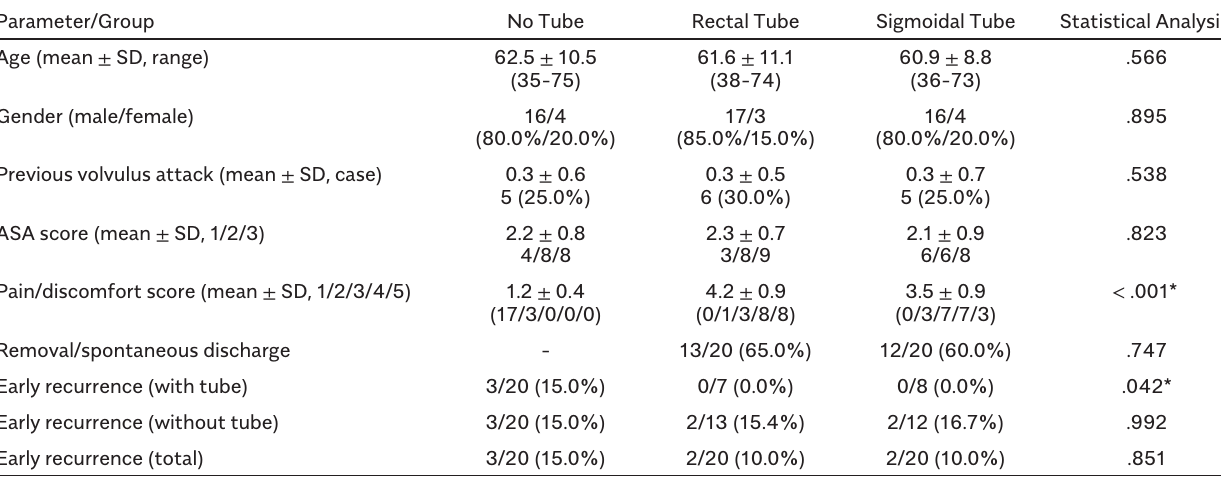
Table 1. The Parameters and the Statistical Analyses